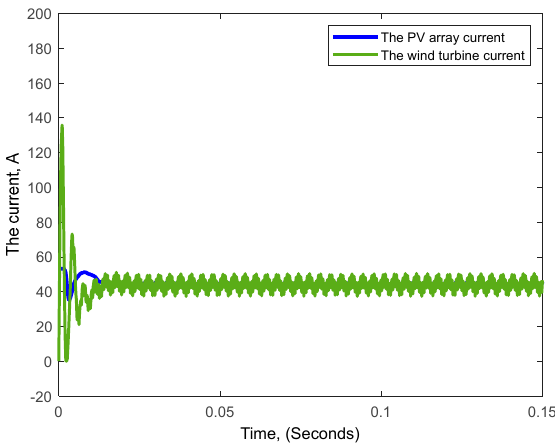
Figure 5. The DC input currents of the inverters.